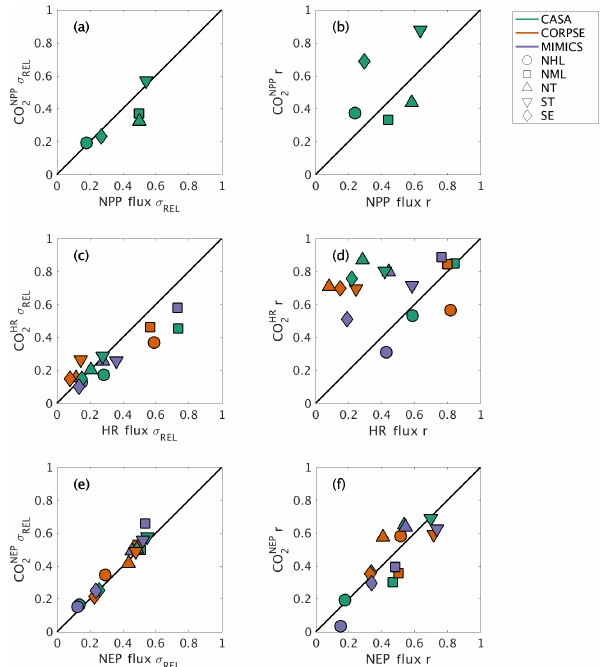
Figure 8. Comparison of regional and global interannual variabil- ity (IAV) from land fluxes and resulting atmospheric CO 2 between 1982 and 2010. (a, c, e) Normalized ratio taken between regional IAV and global IAV magnitude. (b, d, f) Linear correlation between regional IAV and global IAV. The scatterplot shows a direct com- parison of ratio and correlation values for land flux values ( x axes) and corresponding CO 2 ( y axes). Shapes denote the source regions for both land fluxes and CO 2